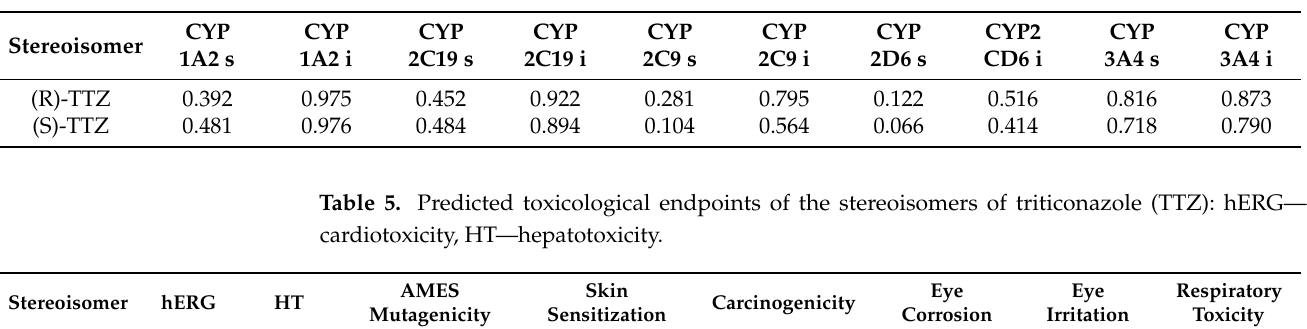
Table 4. Predictions regarding the metabolism of the stereoisomers of triticonazole (TTZ): CYP— cytochrome, s—substrate, i—inhibitor.